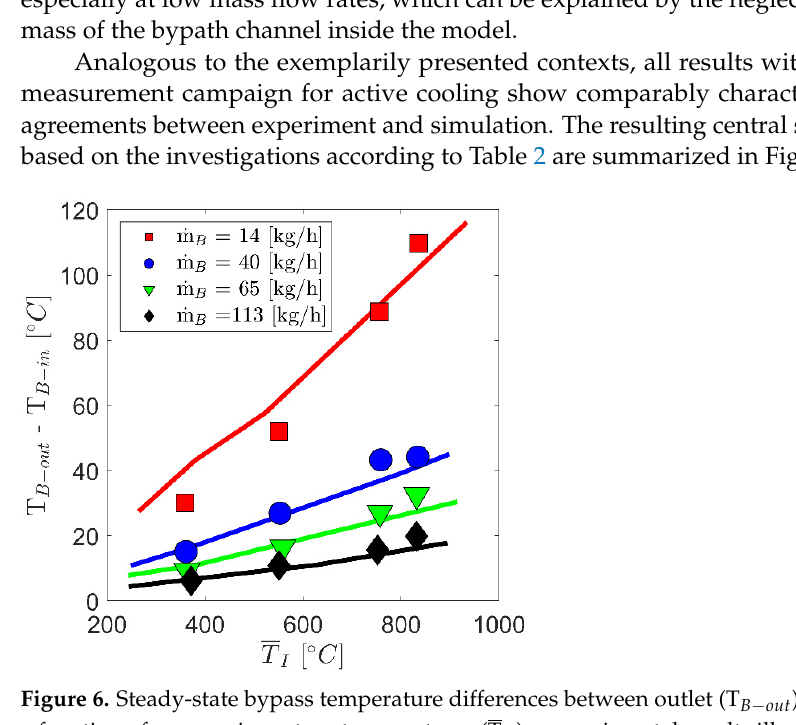
Figure 5. Transient characteristics of the bypass outlet temperature ( T (cid:3003)(cid:2879)(cid:3042)(cid:3048)(cid:3047) ).